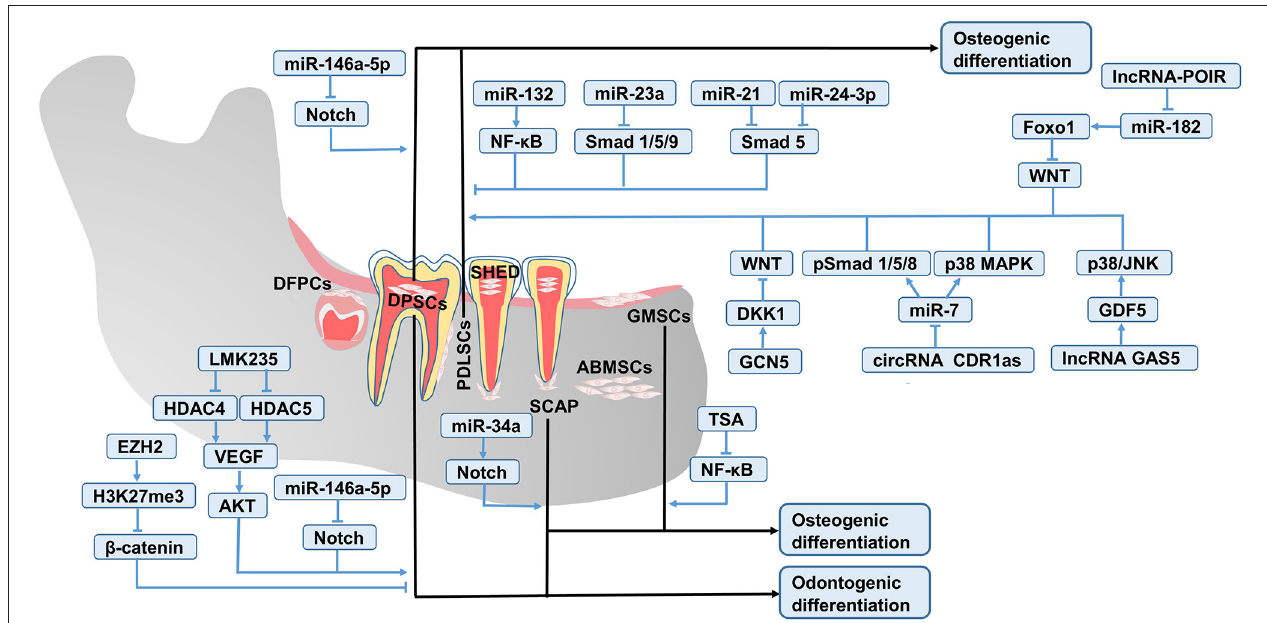
FIGURE 2 | Key pathways involved in the epigenetic regulation of DSC fate. The odontogenic and osteogenic differentiation of DSCs is mediated by the interaction of critical signal pathways such as Wnt, Notch, BMP, AKT/mTOR, MAPK, and NF- κ B.